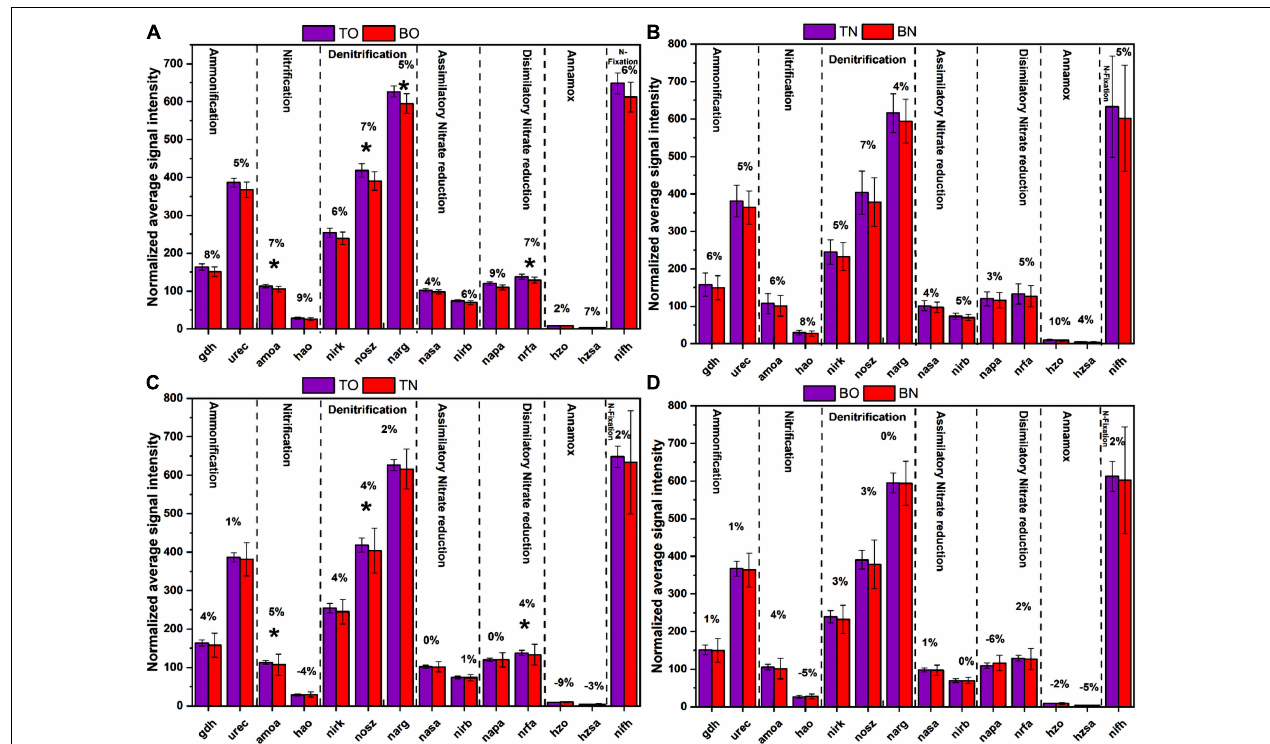
FIGURE 6 | The normalized average signal intensity of functional genes related to the nitrogen cycle. (A) The figure shows significantly upregulated genes at the surface sediment portion (TO) compared with the bottom portion (BO) of the oyster site. (B) The figure shows a comparison between the surface sediment portion (TN) compared with the bottom portion (BN) of the reference site. (C) The figure shows significantly upregulated genes at the surface sediment portion (TO) of the oyster site compared with a surface portion (TN) of the reference site. (D) The figure shows significantly upregulated genes at the bottom sediment portion (BO) of the oyster site compared with the bottom portion (BN) of the reference site. Error bars denote the standard deviation (SD) of the mean ( n = 16), and a % sign indicates the percent change. An asterisk indicates significant differences between groups at p <